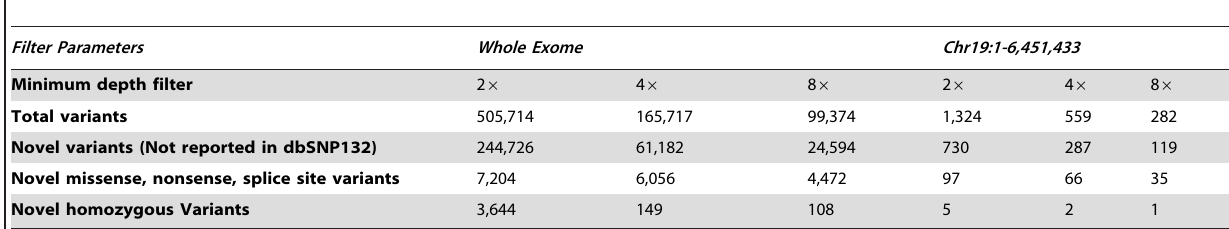
Table 3. Number of variants (SNPs) compared to the reference genome (hg19) with differing minimum depth filter and annotation